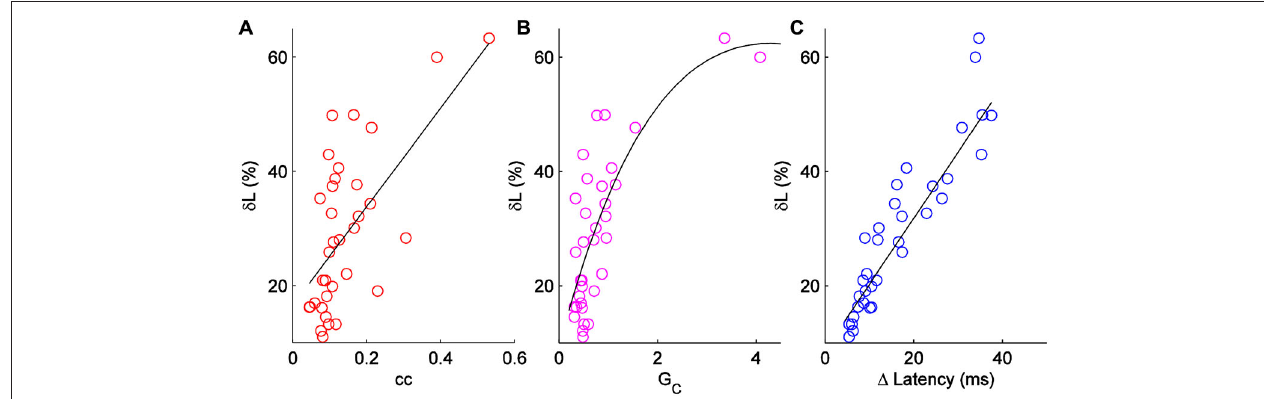
FIGURE 3 | Comparison of δ L to other measures of electrical synapse strength. (A) δ L plotted against coupling coefficient cc in each direction for a set of n = 18 pairs. R 2 = 0.38. (B) δ L plotted against coupling conductance G C ; R 2 = 0.56. (C) δ L plotted against absolute change in latency for each cell in 18 pairs.